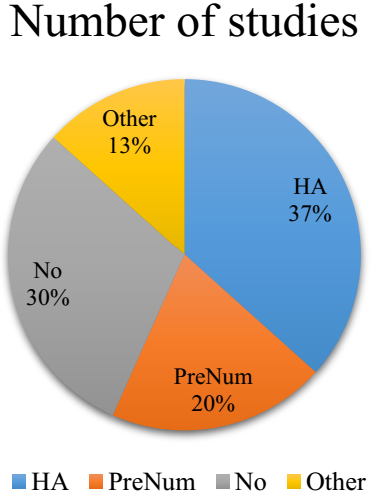
Figure 1. The statistical analysis of 30 most recent publications which used recursive feature elimination (RFE) for feature selection. HA: Used the highest classification accuracy as the decision variant; PreNum: Used a pre-defined number of features as variant; No: Represents that no choice was made; Other: sed other variants for feature selection.